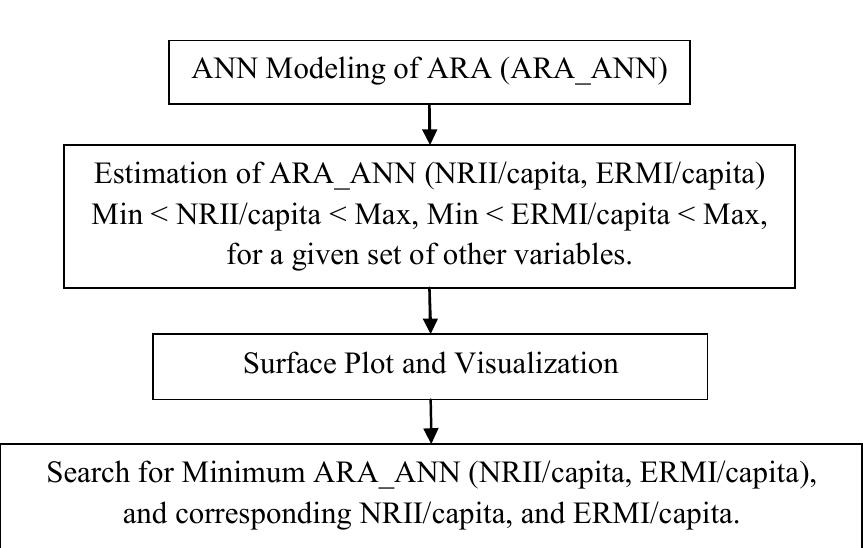
Figure 2. Flow chart for the safe NRII and EMRI limits estimation process.